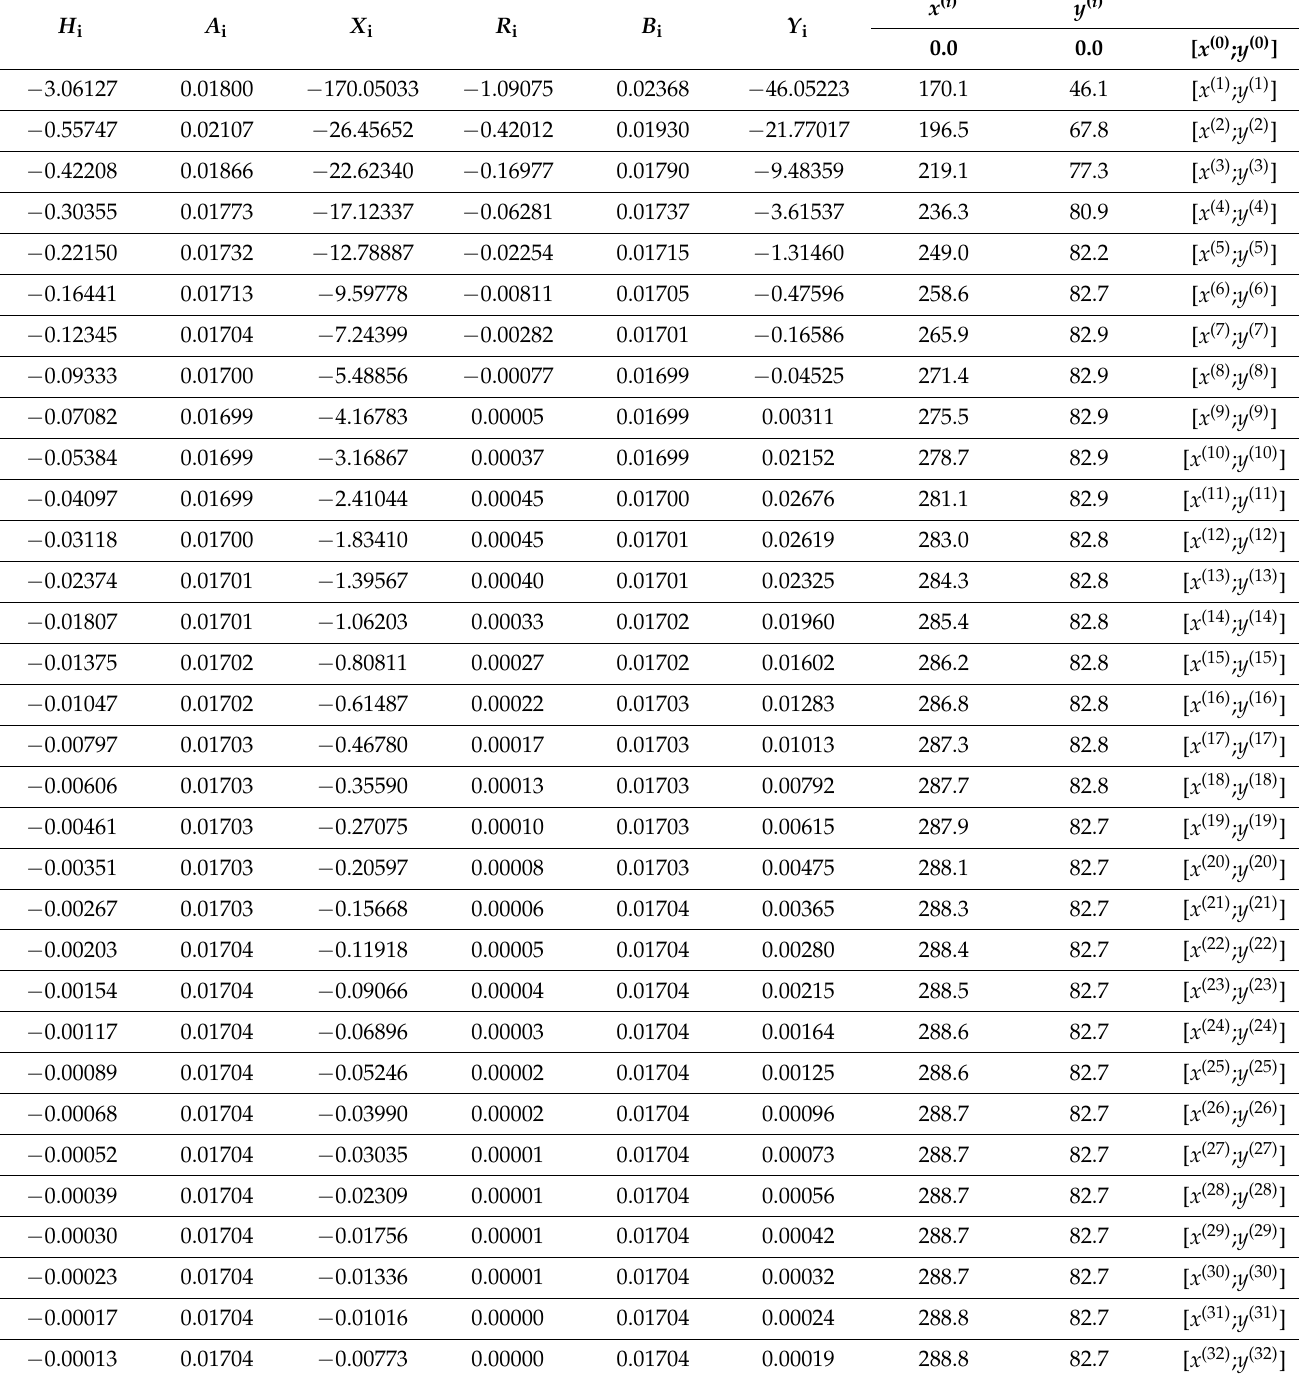
Table 2. Iteration procedure for calculating the optimal position of the distribution